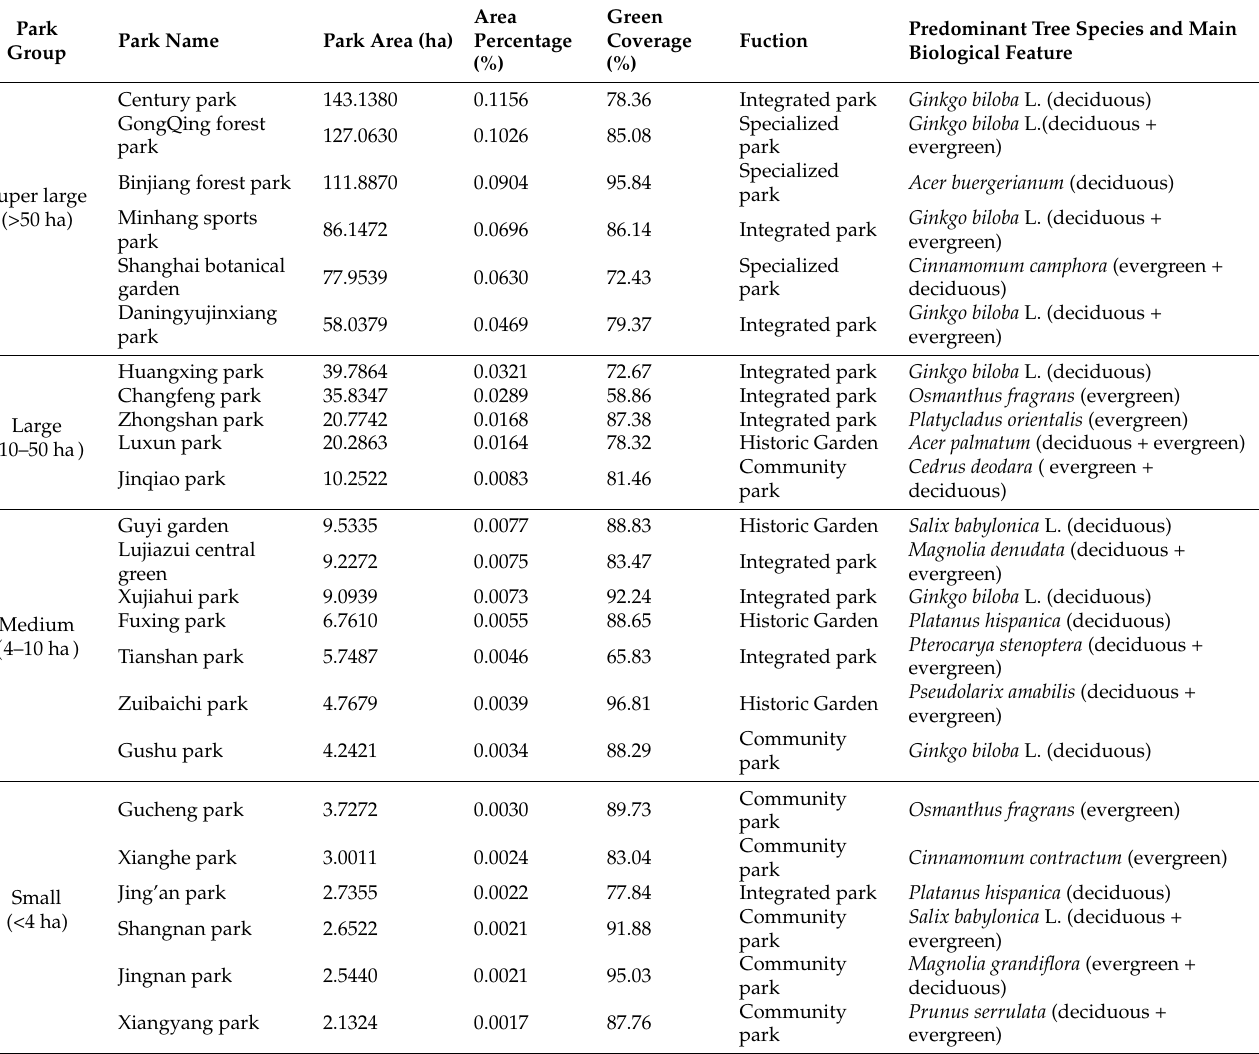
Table 1. Statistical description of 24 Urban Parks in